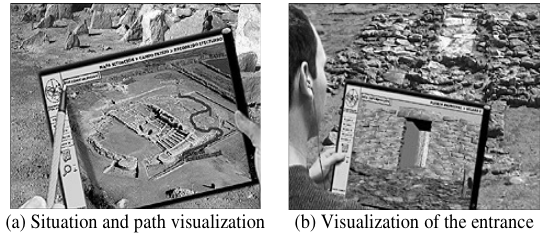
Figure 4. Visit to the fortress of Arbeca in augmented reality (Aguiló et al, 2001).